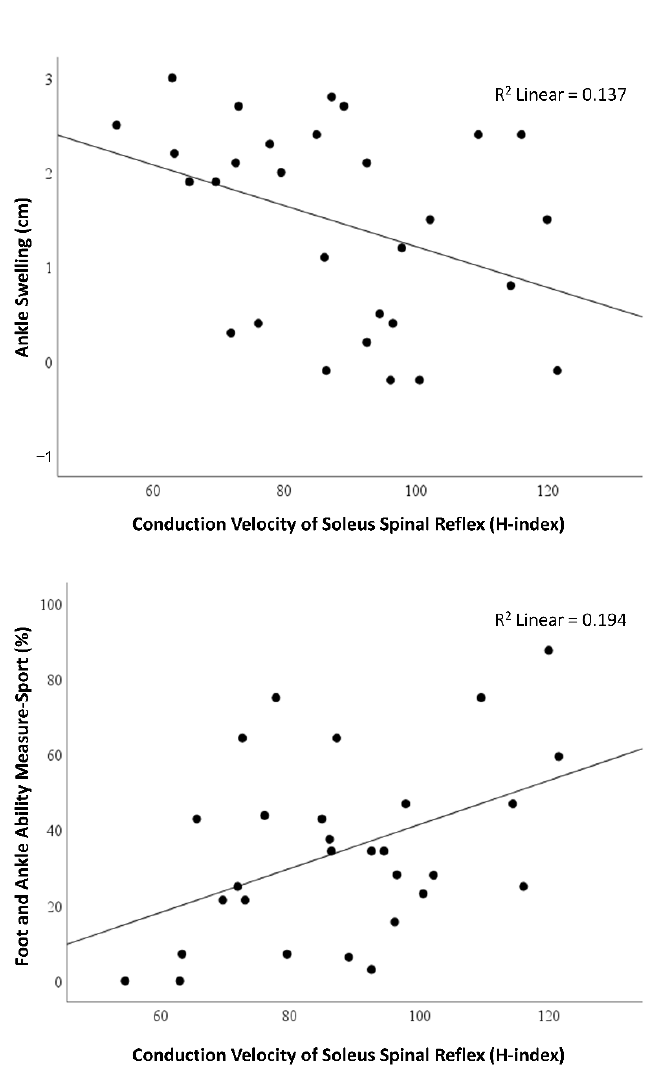
Figure 3. Relationship between the soleus H-index and acute symptoms: ankle swelling ( top ) and self-reported ankle function during sports activities ( bottom ) in patients with ALAS.